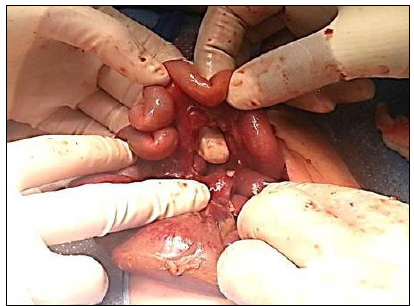
Figure 2: Intra operative finding after reduction of the hernia contents showing congenital mesenteric defect in the mid-ileum through which loops of small bowel herniated resulting in gangrenous